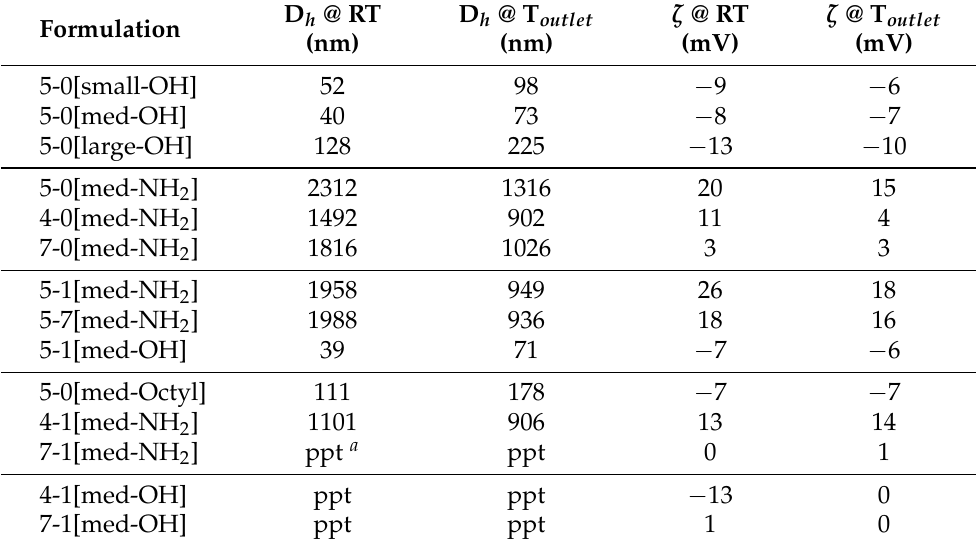
Table 2. Hydrodynamic diameter (D h ) and zeta potential ( ζ ) values for excipients in feed buffer at room (RT, 25 °C) and outlet temperature (T outlet , 70